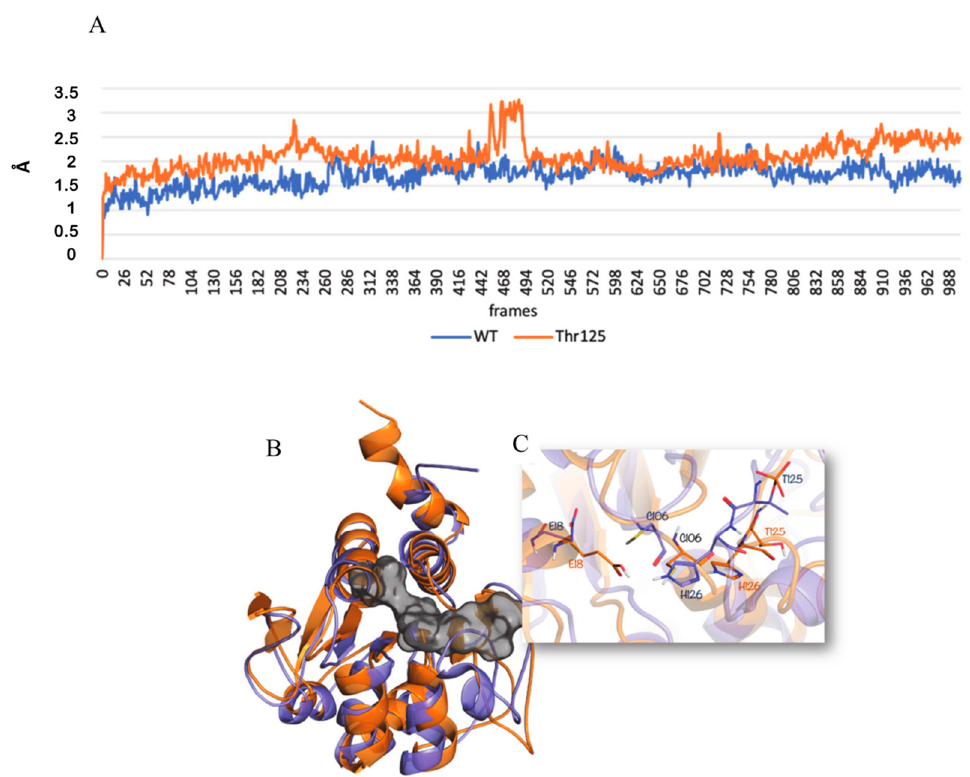
Figure 7. ( A ) Root Mean Square Deviation (RMSD) trend of non-phosphorylated DJ-1 (blue line) and phosphorylated DJ-1 at position 125 (orange line); 3D representation of ( B ) DJ-1 protein non-phosphorylated and DJ-1 protein phosphorylated overlapped, shown as orange and slate cartoon, respectively. The catalytic binding site is represented as a gray surface; ( C ) DJ-1 catalytic binding site, the residues are shown as orange and slate sticks for the non-phosphorylated and phosphorylated DJ-1, respectively.